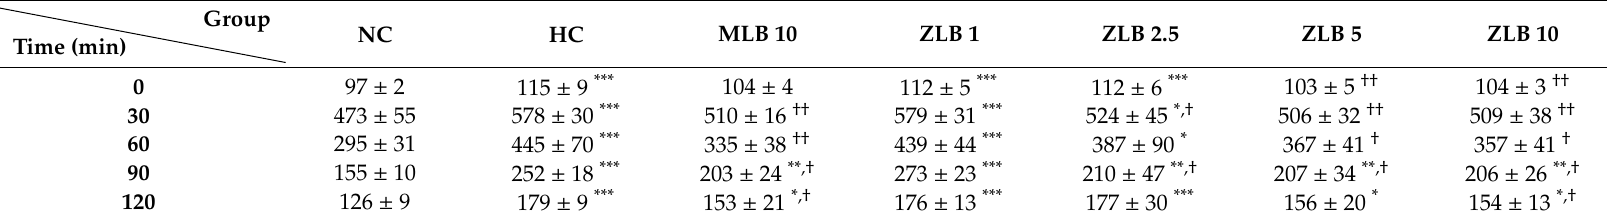
Table 3. E ff ects of MLB and ZLB on the glucose tolerance the levels of blood glucose were measured every 30 min for 2 h three weeks after administration of MLB or